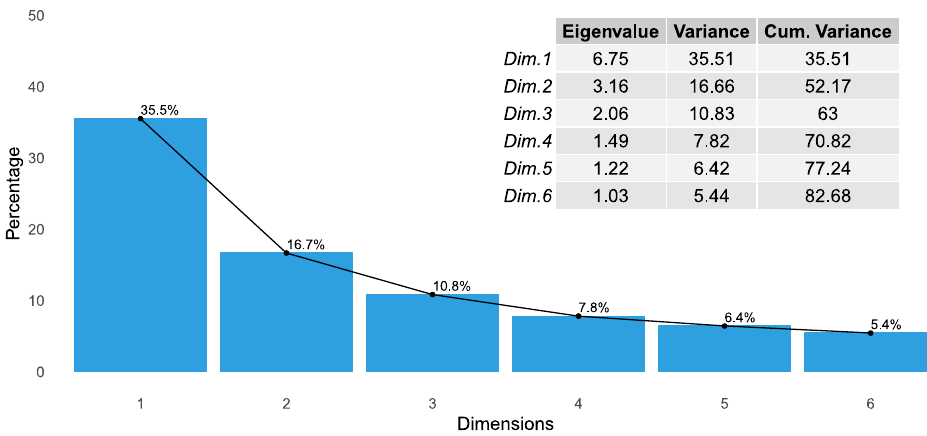
Figure 2. The explained PCs of the total variance and eigenvalues for each of the